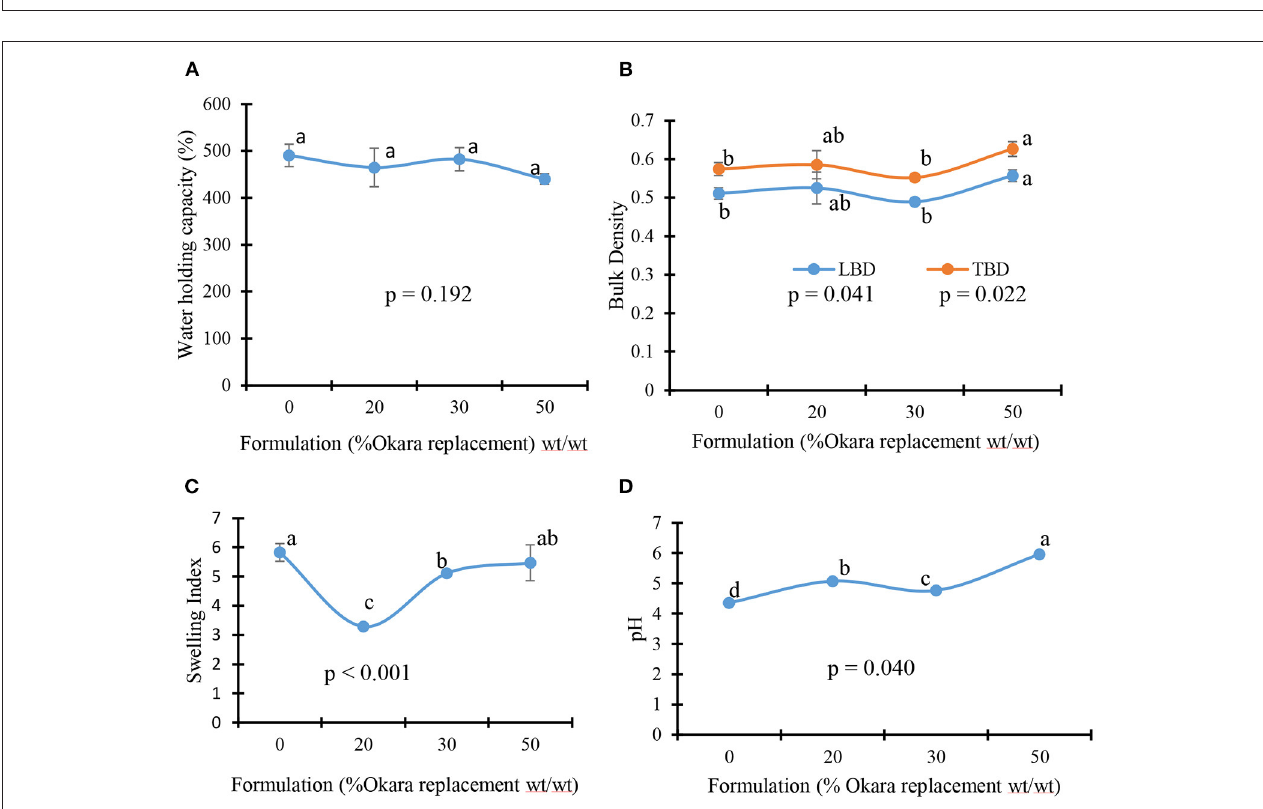
Frontiers in Sustainable Food Systems |